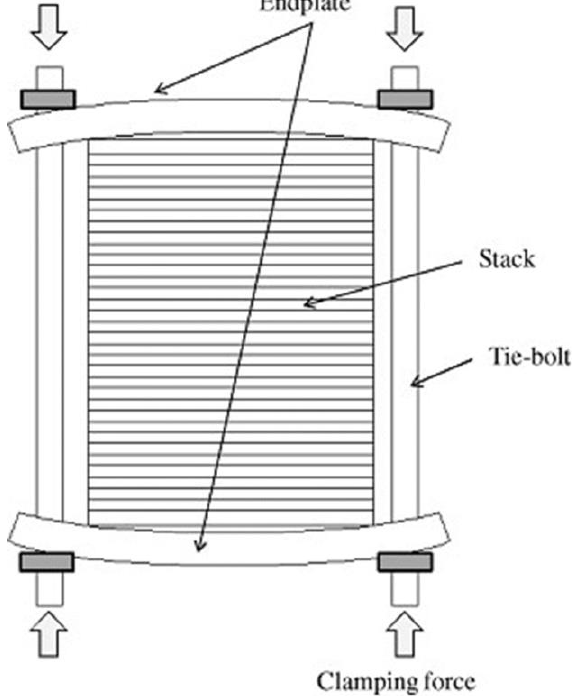
Figure 10. Deflection of end plates along the edges [149] (license no. 5172551168359).